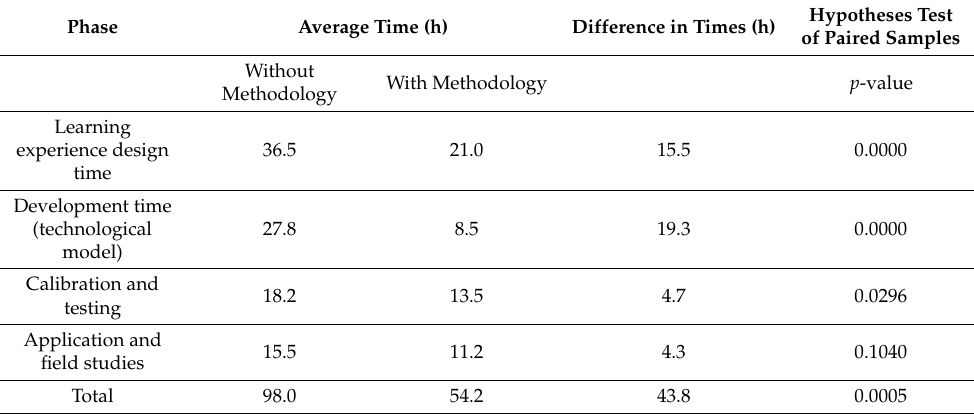
Table 3. Hypotheses test of the paired samples of reported times with and without VIS-HAPT methodology.